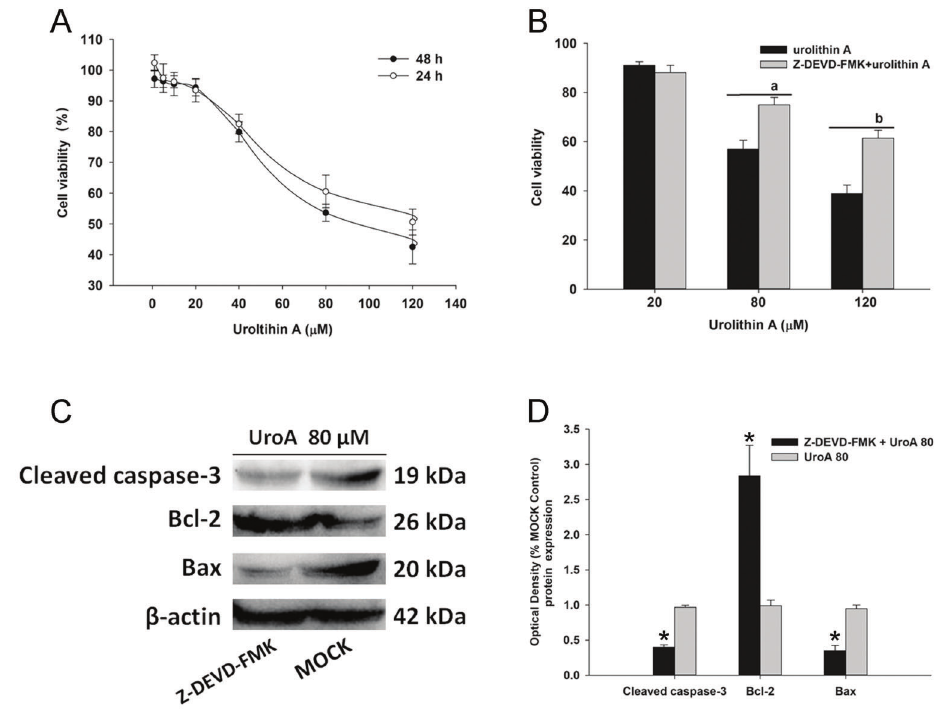
Figure 1. Urolithin A (UroA) suppressed HepG2.2.15 cell proliferation via caspase-3 dependent apoptosis. A , HepG2.2.15 cells were administrated with 0-120 m M of urolithin A for 24 or 48 h. Cell viability was assessed by a CCK assay and the data were normalized to normal controls. B , The caspase-3 inhibitor Z-DEVD-FMK alleviated urolithin A-induced HepG2.2.15 cell death (80 or 120 m M). The cells were incubated in the absence or presence of Z-DEVD-FMK (20 m M) for 6 h prior to urolithin A treatment, and then incubated for 48 h. Data are reported as means ± SD, n=3. a,b P o 0.05 vs 80 or 120 m M of urolithin A group. C , and D , After urolithin A (80 m M) administration for 48 h, western blot analysis for the protein expressions of cleaved caspase-3, Bcl-2, and Bax was performed in the absence or presence of Z-DEVD-FMK. Data are reported as means ± SD, n=3. *P o 0.05 compared to the 80 m M urolithin A group ( t